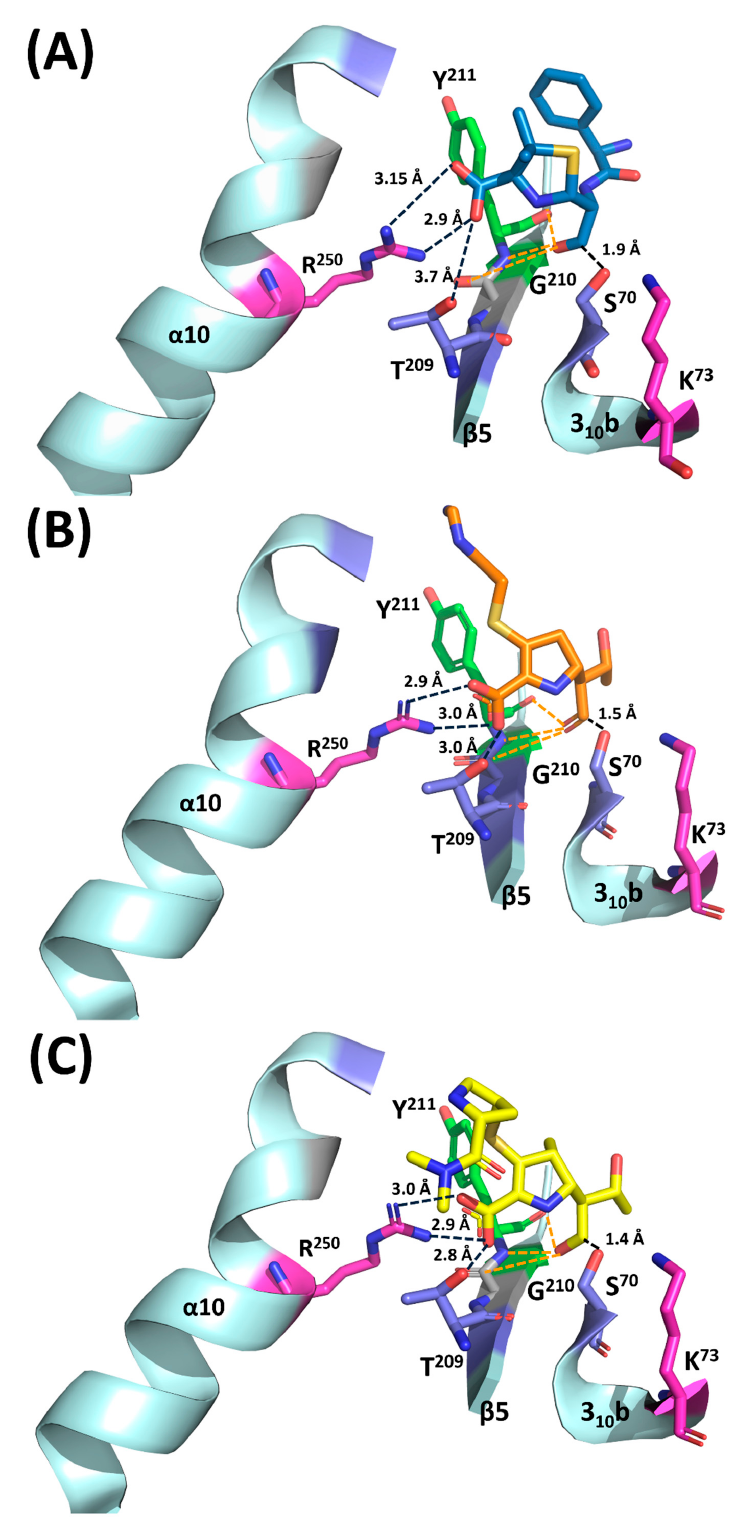
Figure 3. Interactions between ampicillin, imipenem, meropenem and the active site of OXA-48. ( A ) Modeling of ampicillin in the substrate pocket of OXA-48; ampicillin is depicted as blue stick. ( B ) Imipenem bound to OXA-48 in the substrate pocket (6P97); imipenem is depicted as orange stick. ( C ) Meropenem bound to OXA-48 in the substrate pocket (6P98); meropenem is depicted as yellow stick. Potential H-bonds between the residues of OXA-48 and carboxylate oxygens of the original β -lactam ring (orange) and that of the fused ring (black) are shown as dash